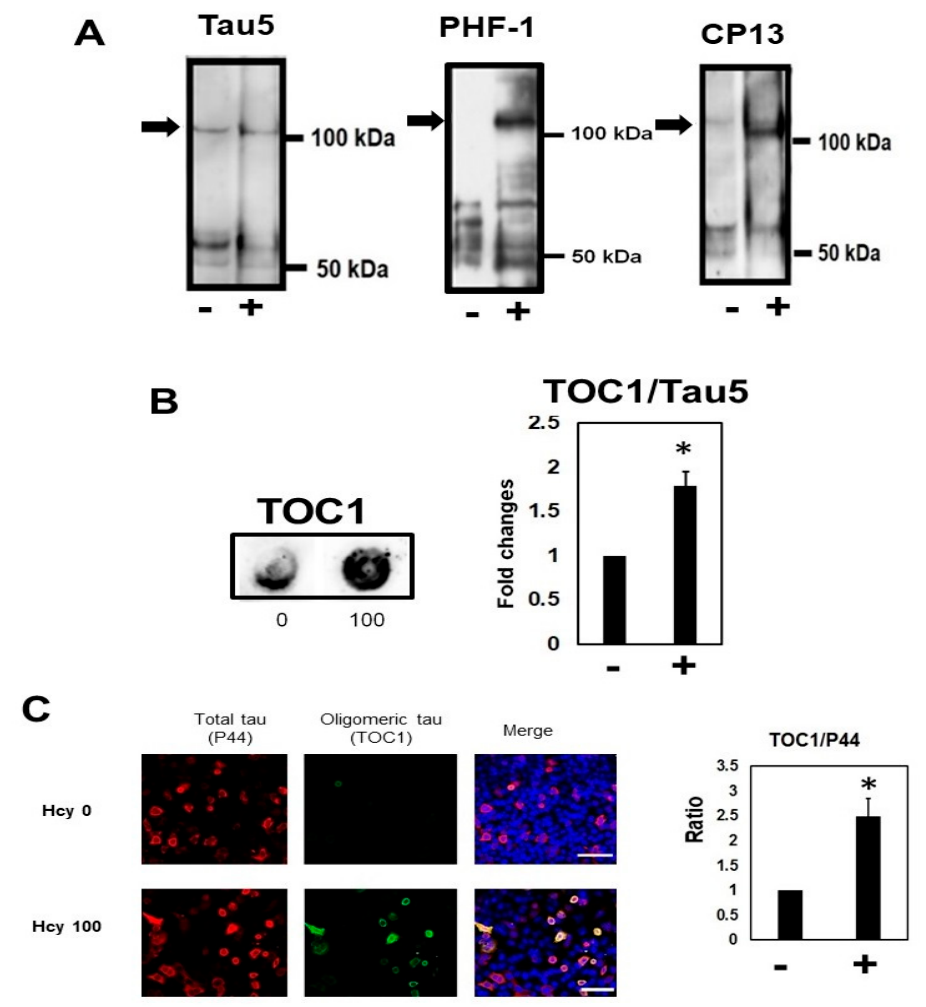
Figure 8. Homocysteine (Hcy) increased oligomeric tau in M1C cells. Hcy increased high molecular weight oligomeric tau in the sarkosyl soluble, tris insoluble (SN2) fraction. Hcy increased total (Tau5) and phosphorylated (PHF-1, and CP13) oligomeric tau (arrow) in the tris insoluble sarkosyl soluble fraction in non-reducing conditions. − : 0 µ M Hcy, +: 100 µ M Hcy treated cells ( A ). Hcy increased oligomeric tau, detected by tau oligomer complex 1 (TOC1) antibody, in dot blot ( B ) and immunocytochemical studies ( C ). − : 0 µ M Hcy, +: 100 µ M Hcy treated cells. Bar: ± SD, * p < 0.05. Cell viability was decreased by Hcy, in both tau induced cells (Figure 9C), and non-induced cells (Figure S1). Consistent with induction of apoptotic cell death, cleaved caspase 3 was increased by low to high doses of L-Hcy (Figure 5A). The viability of mouse neurons was also measured using the ATP-dependent cell viability assay. One hundred to 10,000 µ M L-Hcy induced cell death in mouse primary cultured neurons (Figure